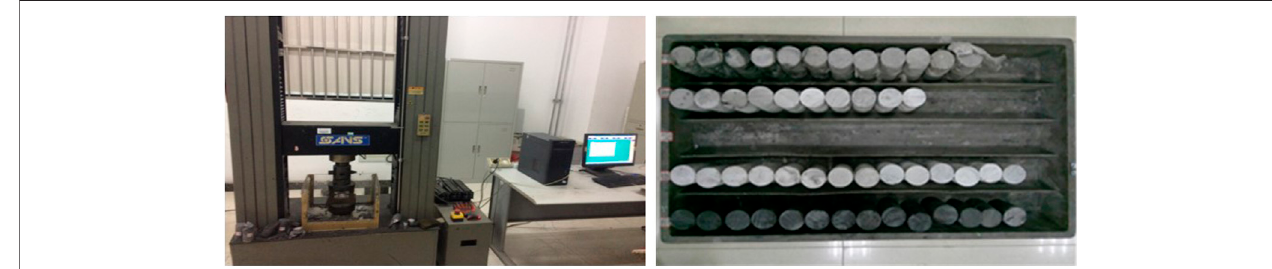
FIGURE 5 | Rock mechanics test equipment and samples.